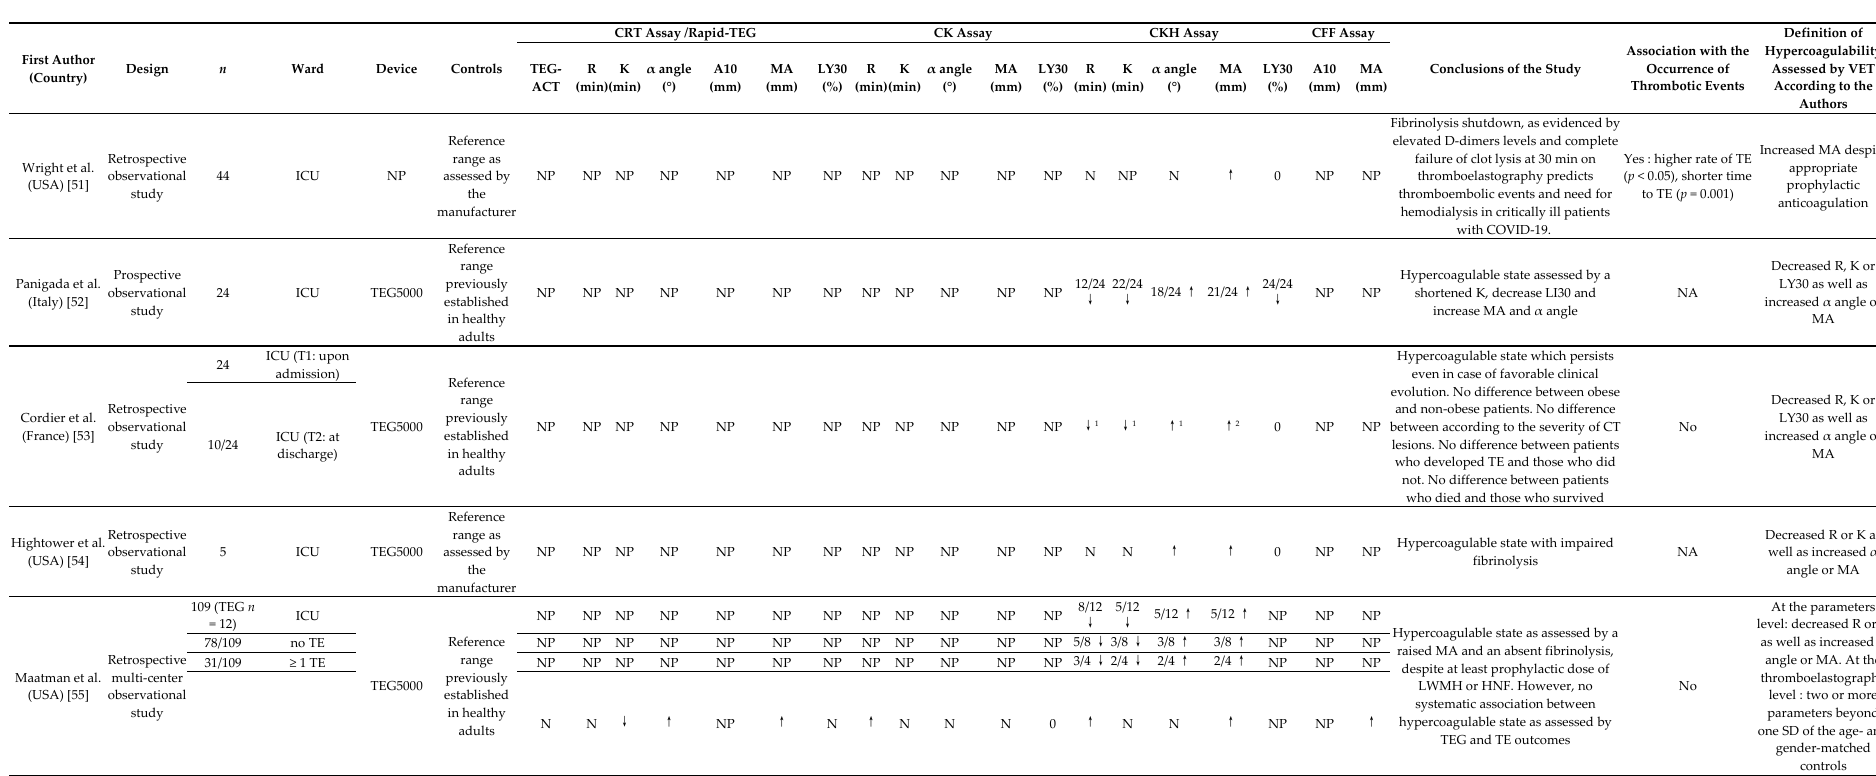
Table 8. Main findings of studies reporting TEG results.